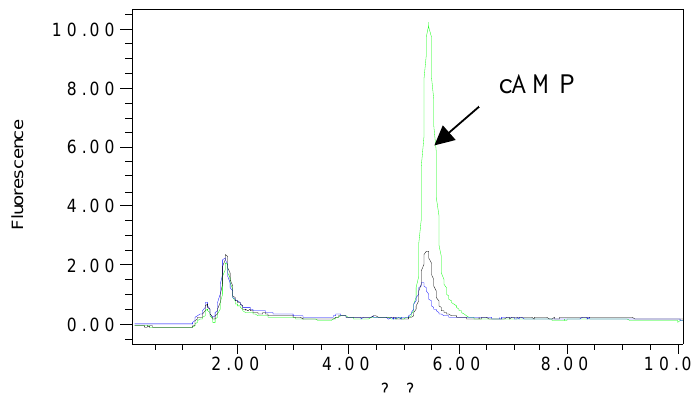
Figure 3. Chromatogram of cAMP (1pmol/ml, 0.1 pmol/ml and 0.01 pmol/ml) in water using TBAS buffer with